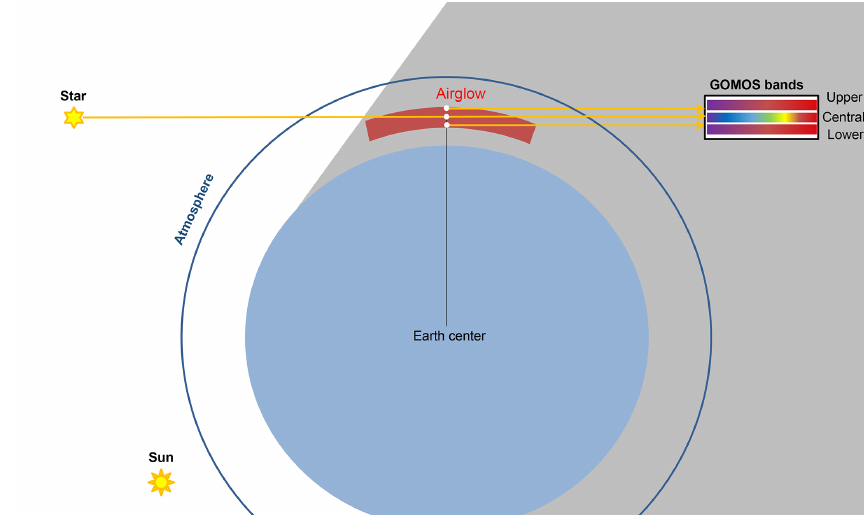
Figure 1. Schematic view of the GOMOS stellar occultation observations. The star transmission spectra are recorded in the central band of the instrument detector, while the atmospheric background radiation is imprinted in the upper/lower bands. The O 2 A-band and OH airglow emissions are detected in the limb observations. For each star spectrum, one upper and one lower spectrum are recorded simultaneously.